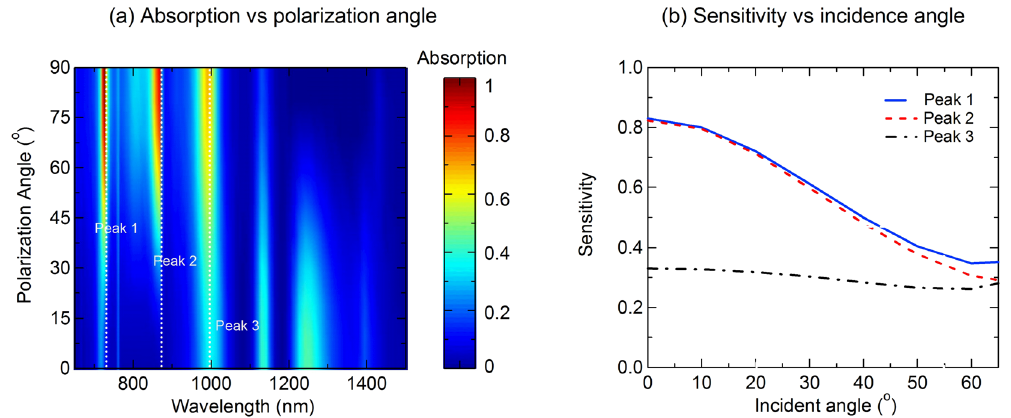
Figure 7. ( a ) Absorption spectrum as a polarization angle under normal incidence and ( b ) sensitivity of triple absorption band as a function of incidence angle of the narrowband